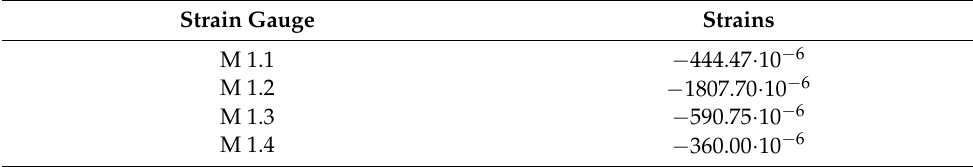
Figure 6. Position of measuring set on sample CS1. Table 3. Strain gauge measurements for specimen